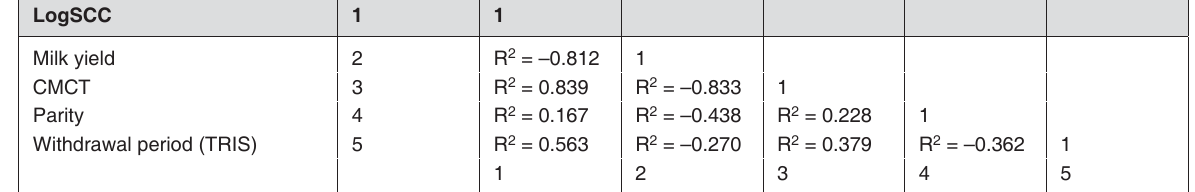
FIG. 1 Goats with clinical mastitis. The mean SCC of udder halves with clinical mastitis in treatment groups (T1 = Curaclox LC, T2 = Spectrazol Milking Cow, T3 = Rilex ine 200 LC) versus control group (Rx =